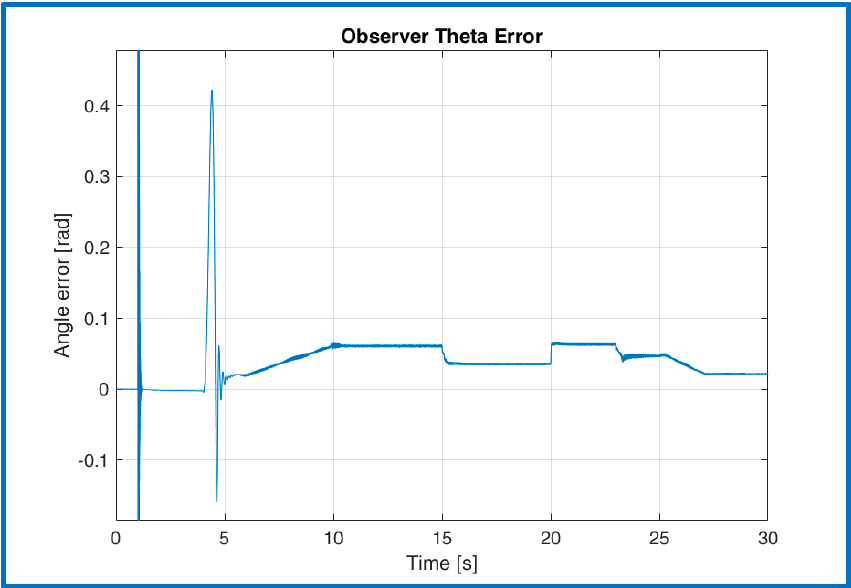
Figure 20. Observer theta error with inverter and continuous cable model.